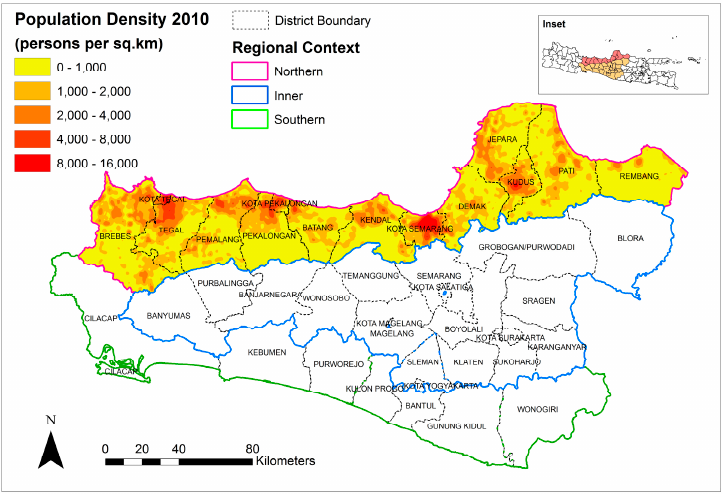
Figure 3. Population density in the northern coastal region of Central Java, 2000 and 2010.